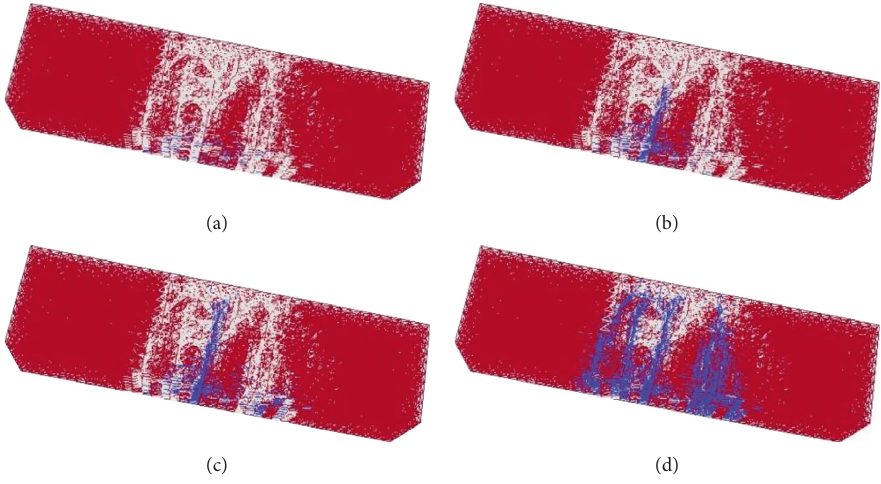
Figure 8: Crack patterns in UHPFRC at different steps: (a) 100, (b) 500, (c) 1000, and (d) 5000.